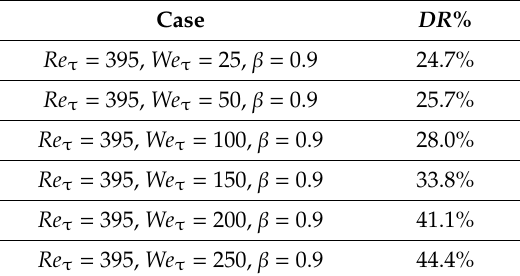
Table 5. DR % at di ff erent We τ of the RSM for high Re τ